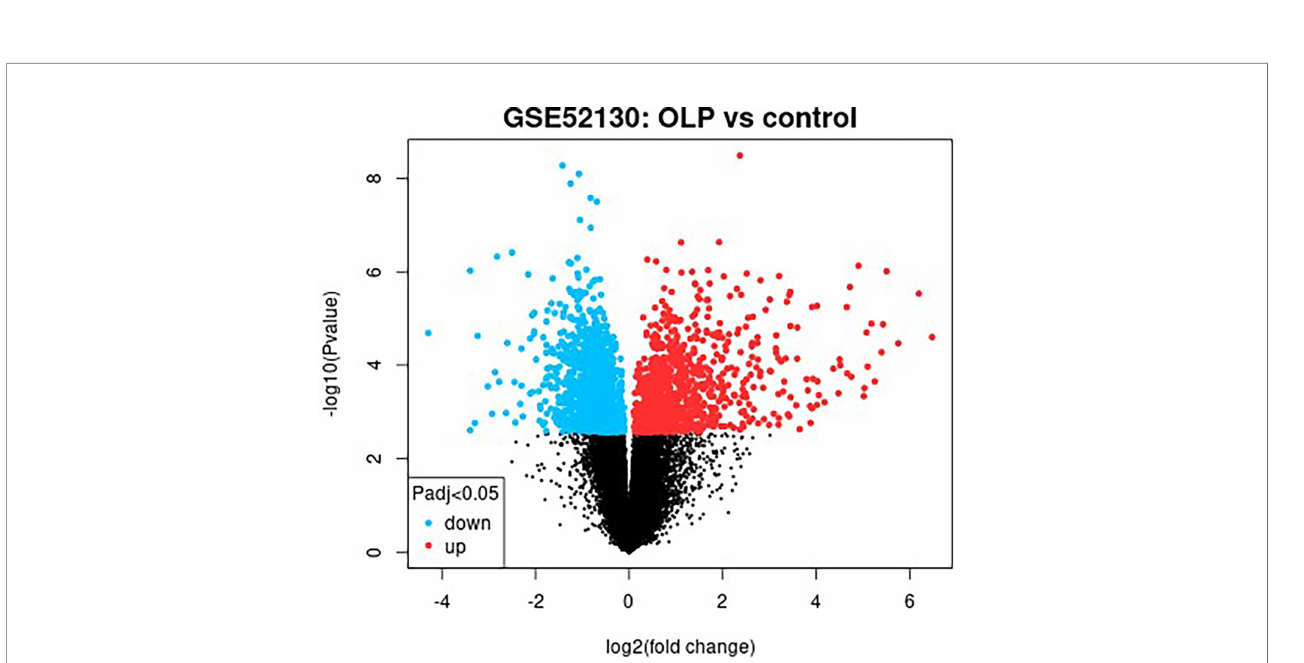
FIGURE 6 | Differential gene screening results of the OLP and HC groups in the GSE52130 data